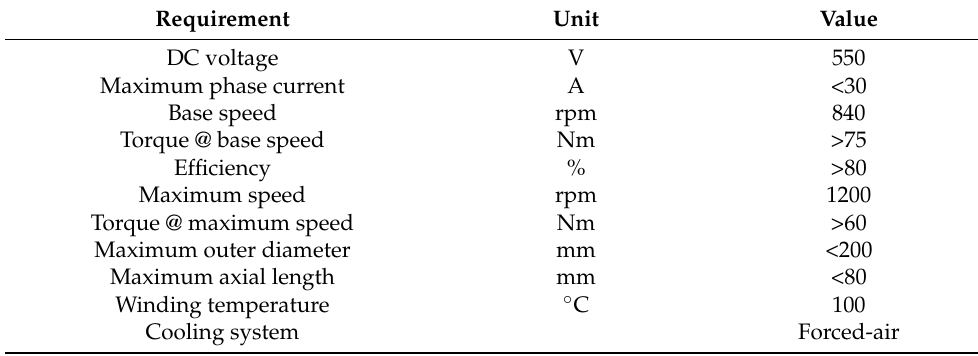
Table 1. AFPM motor